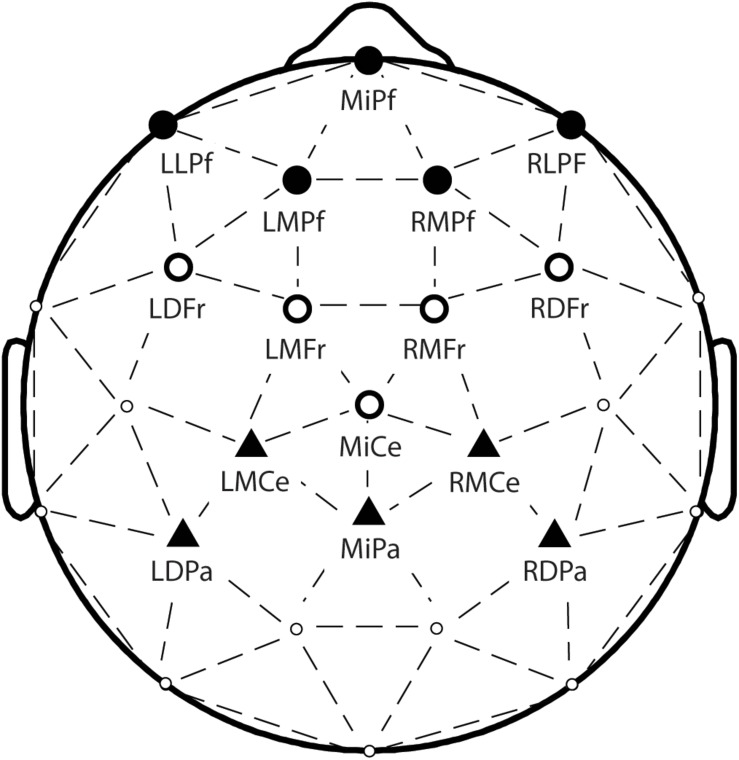
Topographical plot of electrodes, with labels provided for the electrodes included in analyses. Black circles, white circles, and black triangles correspond to the anterior frontal, frontocentral, and parietal clusters, respectively.